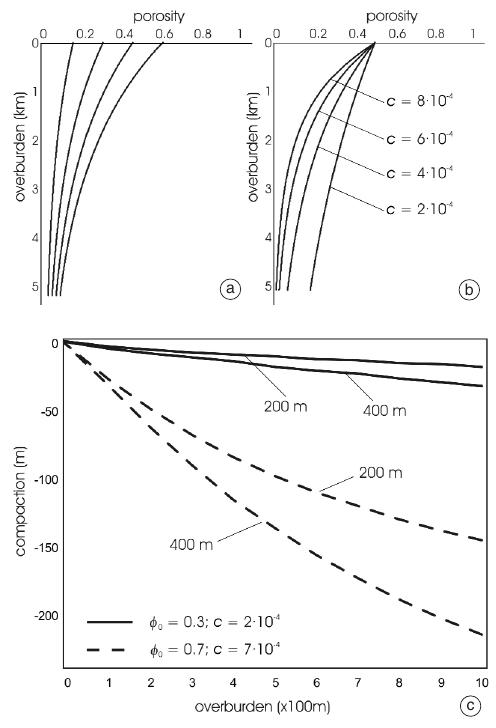
Fig. 3a-c. Reduction of porosity ( i.e. compaction) associated to progressive burial: a) with variable ini- tial porosity and constant compaction factor ( c = 4 ⋅ 10 − 4 ); b) with variable compaction factors ( c ) and constant initial porosity ( φ 0 = 0.5). c) Subsidence induced by compaction of a ‘plastic’layer, for differ- ent initial thicknesses and material properties, as a function of the